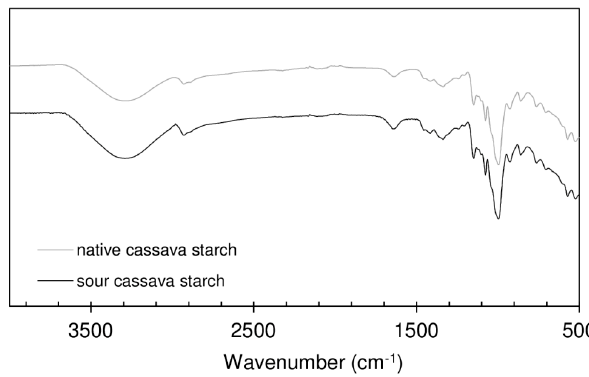
Figure 3. FTIR spectra of native and sour cassava starch in the (4000–500 cm − 1 ) spectral region.